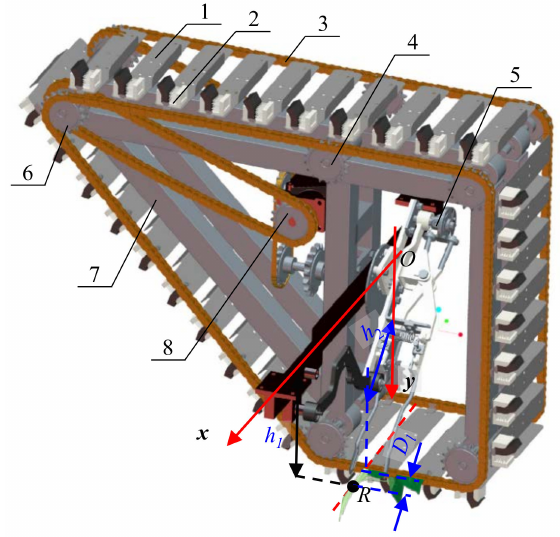
Figure 10. Slip delivery mechanism for slip transplanting. Note: 1, Slip placement board; 2, Slip clamping brush; 3, Double-chain; 4, Sprocket; 5, Slip taking-planting mechanism; 6, Sprocket carrier; 7, Frame; 8,